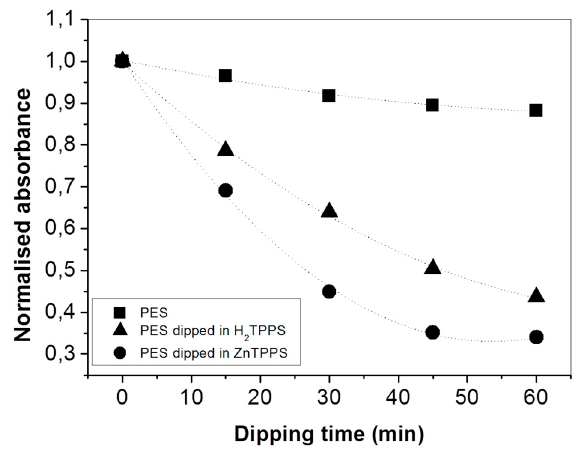
Figure 4. Normalized absorbance variation at λ = 381 nm of a 5 µ M para-nitroaniline (p-NA) water solution upon increasing the dipping time of untreated (black squares) and H 2 TPP- (black triangles) and ZnTPP-treated (black circles) PES mats.